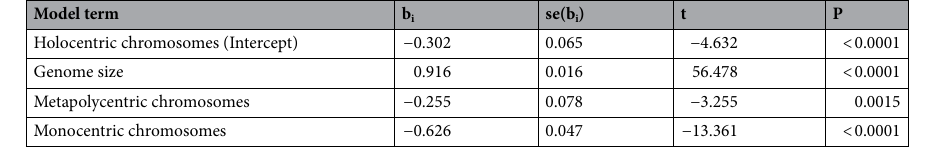
Table 1. Outcome of the additive regression model: Total centromere size ~ Genome size + Chromosomes. The outcome of multiple linear regression model of the relationship of Total centromere size (log-transformed) to Genome size (log-transformed) for different chromosome types. The slope of the regression line (b = 0.916) is the same for all chromosome types. The intercept of the regression line is highest for holocentric chromosomes (b = -0.302), lower for metapolycentric chromosomes (b = -0.302–0.255 = -0.557) and lowest for monocentric chromosomes (b = -0.302–0.626 = -0.928). b i —coefficient estimate, se(b i )—standard error of the coefficient estimate, t—t-statistics, P—significance. Total Centromere Size = -0.302 + 0.916 × Genome size -0.255 × Metapolycentric chromosomes (0 or 1) -0.626 × Monocentric chromosomes (0 or